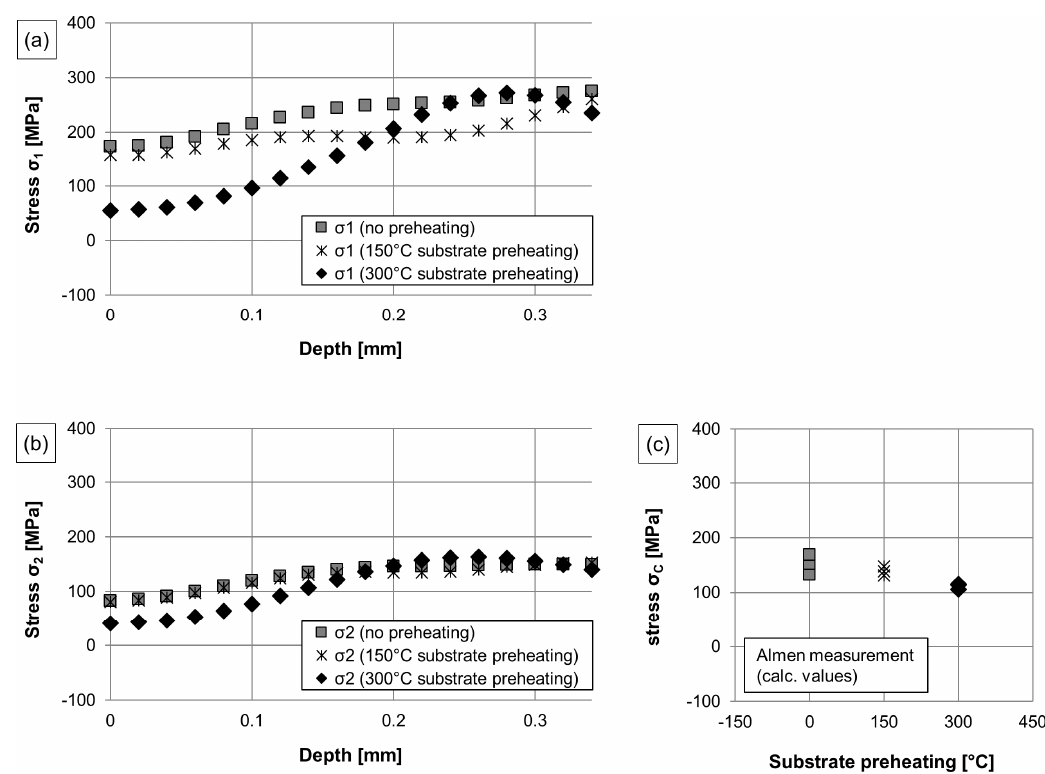
Figure 6. Residual stress distribution along coatings produced with different preheating procedures, determined by using the bore hole drilling strain gage method ( a , b ), and calculated stress states in coatings produced with different preheating procedures using the curvature method ( c ).